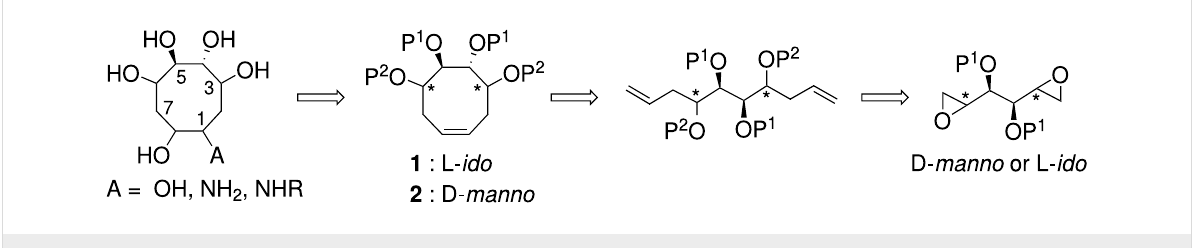
Figure 2: Retrosynthetic